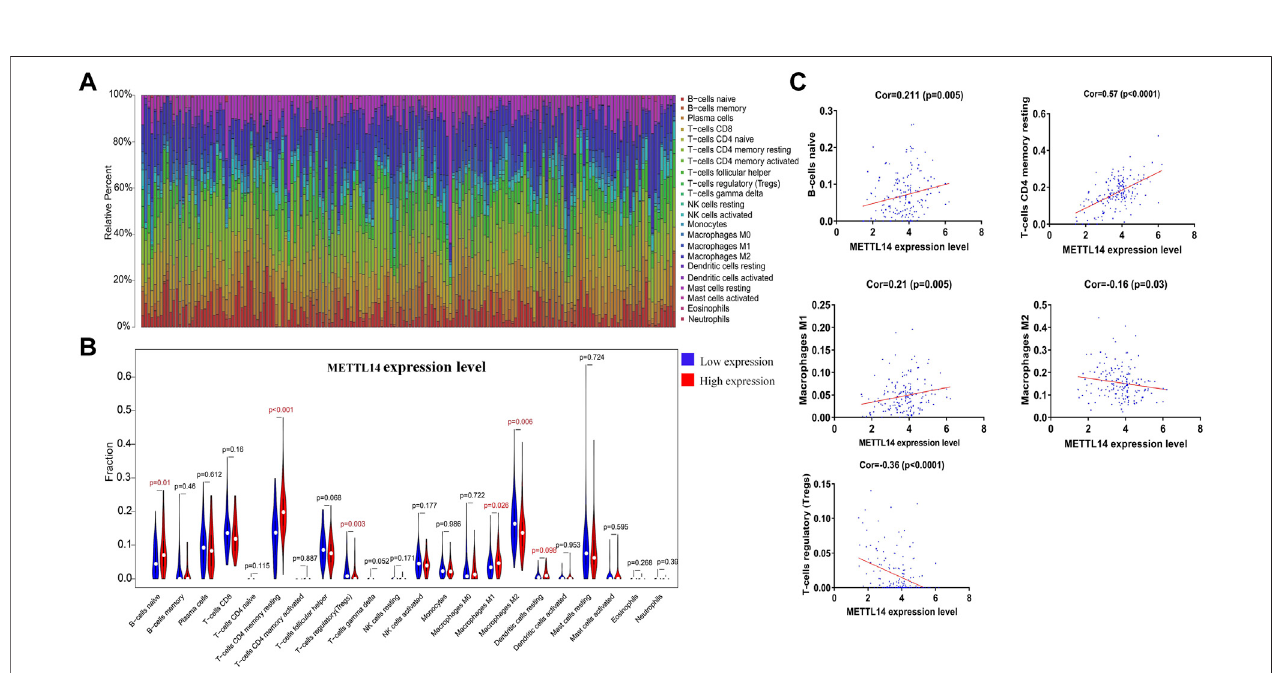
FIGURE6| PotentialassociationbetweenMETTL14expressionandthetumormicroenvironment. (A) Barplotsshowingtheproportionof22speci fi cimmunecells in each of the PCa samples. (B) Violin plot depicting the difference of immune in fi ltration in PCa samples with low or high METTL14 expression. (C) Pearson correlation analysis of fi ve types of immune cell fractions with METTL14 expression ( p < 0.05).